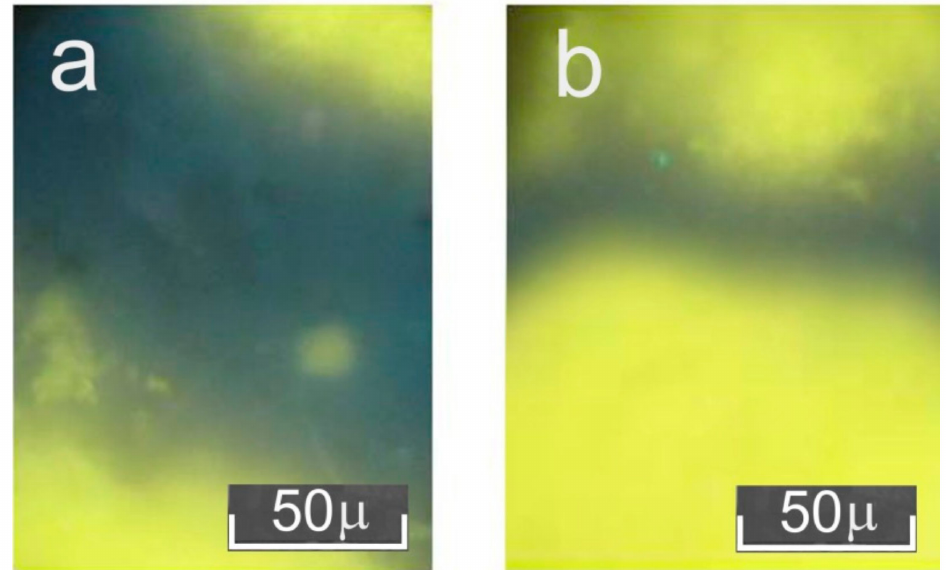
Figure 4. Cathodoluminescence patterns of different parts of studied Gd 0.96 Eu 0.01 Sm 0.01 Tb 0.01 Er 0.01 Nb 0.9 Ta. 0.1 O 4 ceramics after vacuum annealing: ( a ) bottom side of the sample, ( b ) top side of the